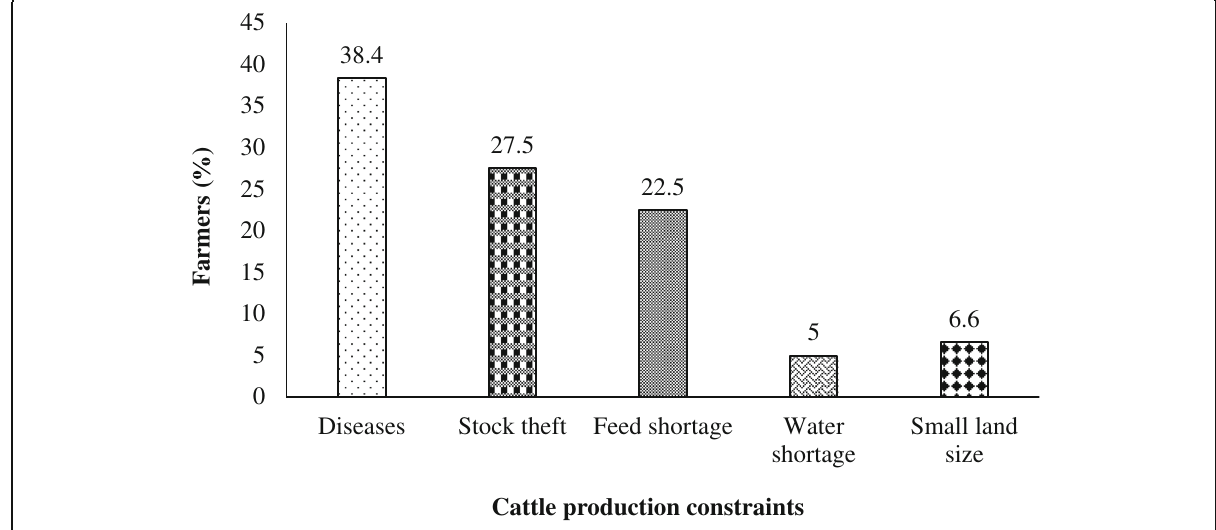
Fig. 1 Cattle production constraints faced by Nguni Cattle Project beneficiaries